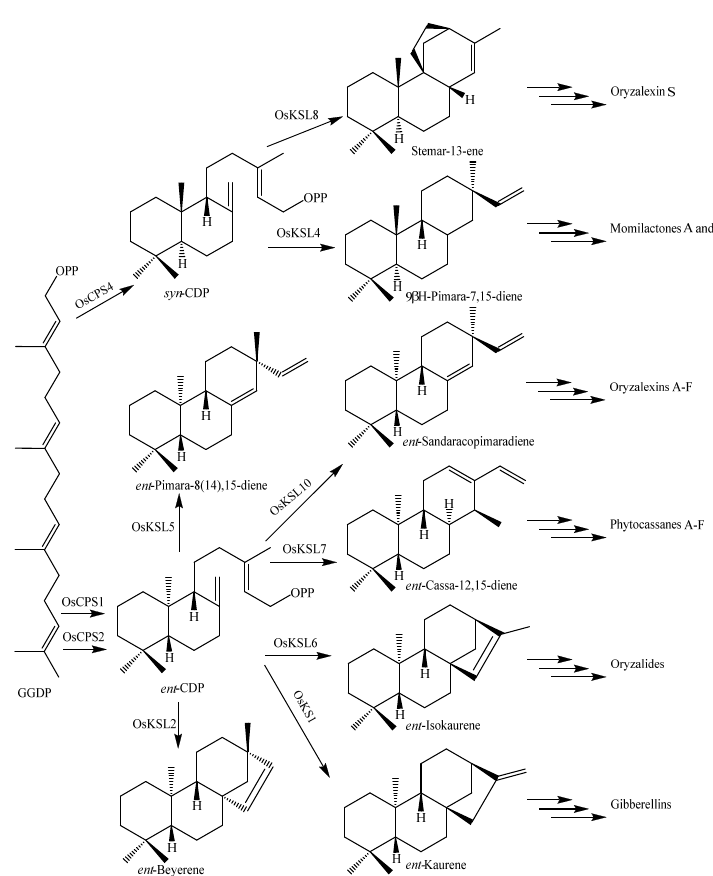
Figure 12. Biosynthesis pathways of the labdane-related diterpenoids in rice [141].